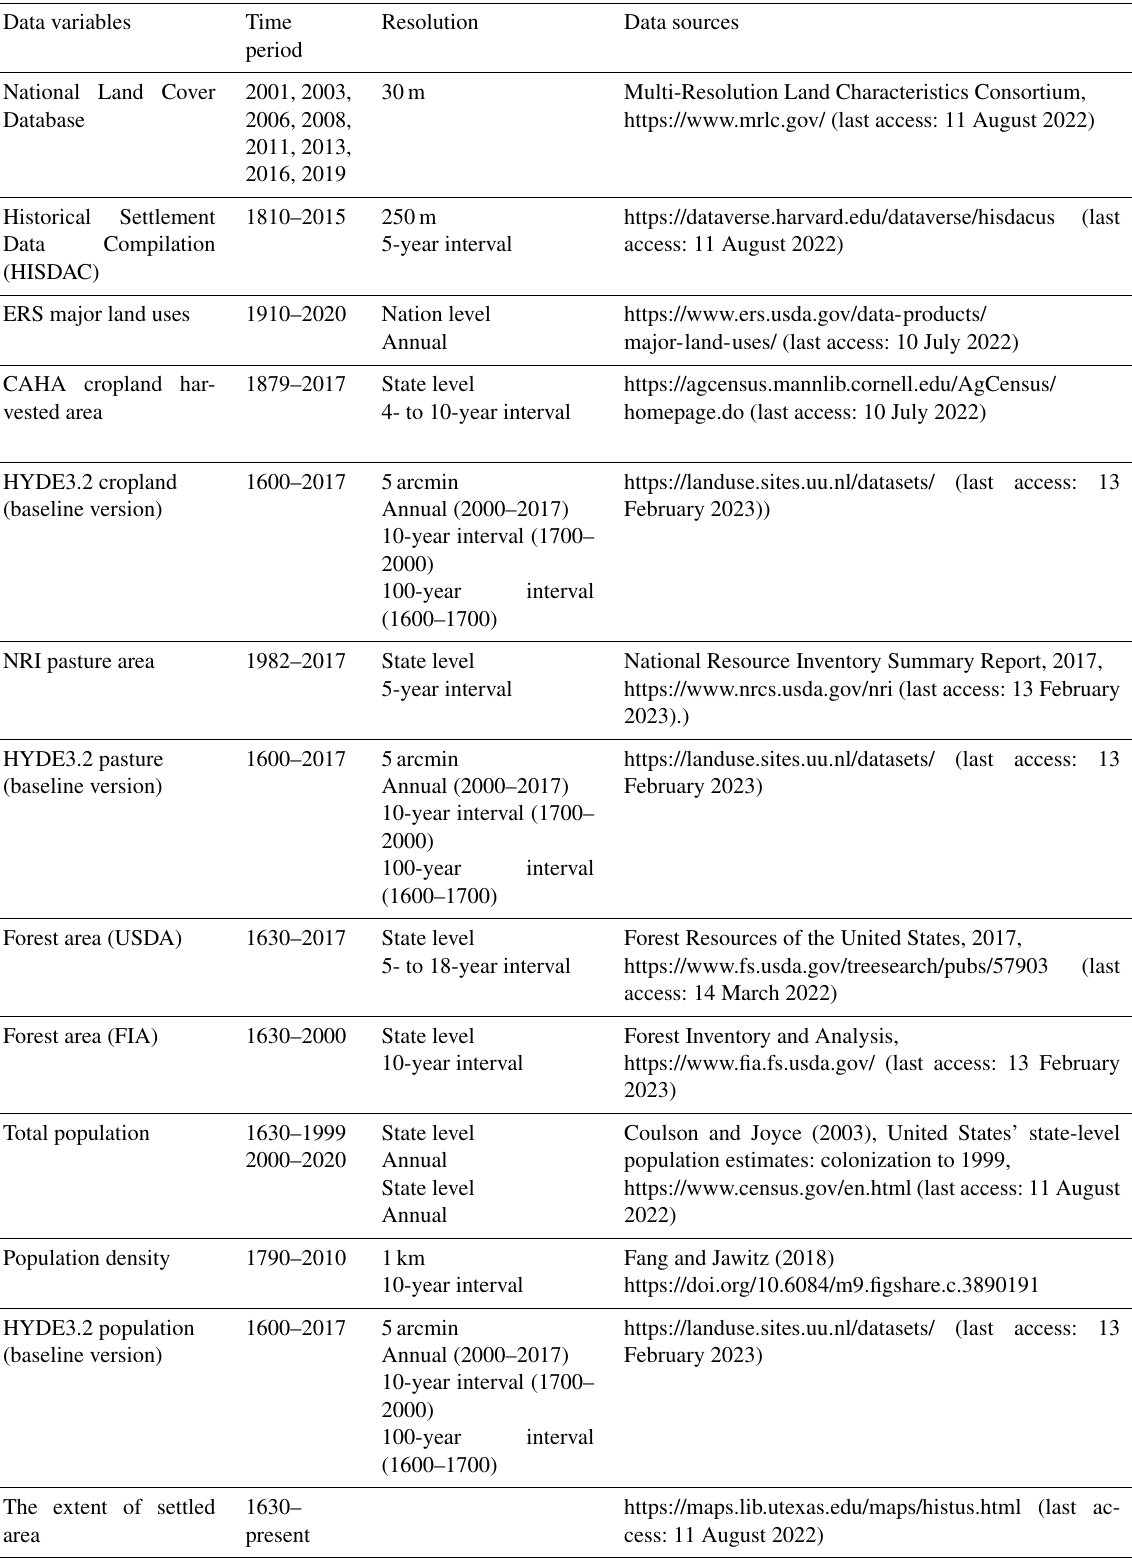
Table 1. Summary of the input